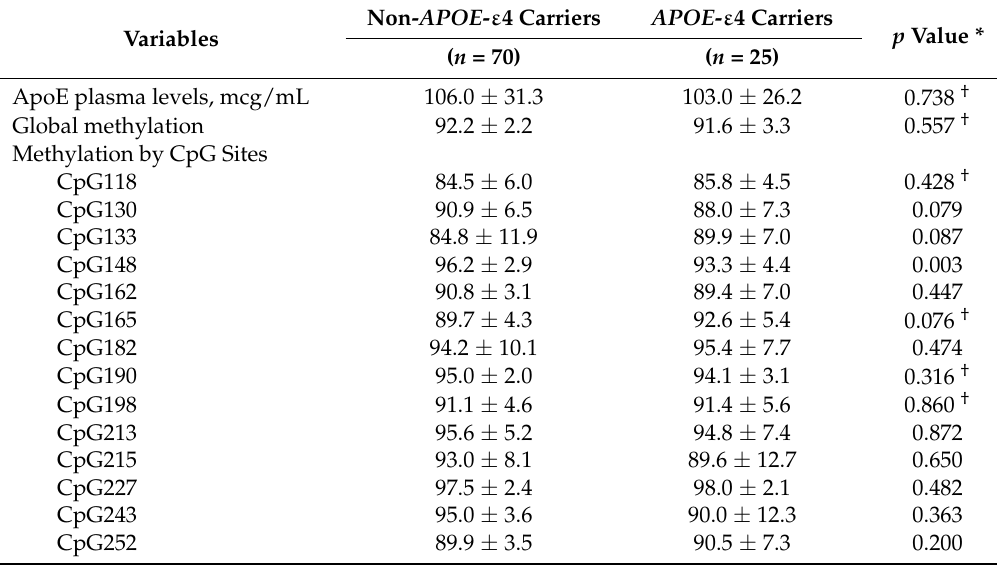
Table 3. Values of ApoE plasma levels and APOE methylation of CpGs sites according to APOE